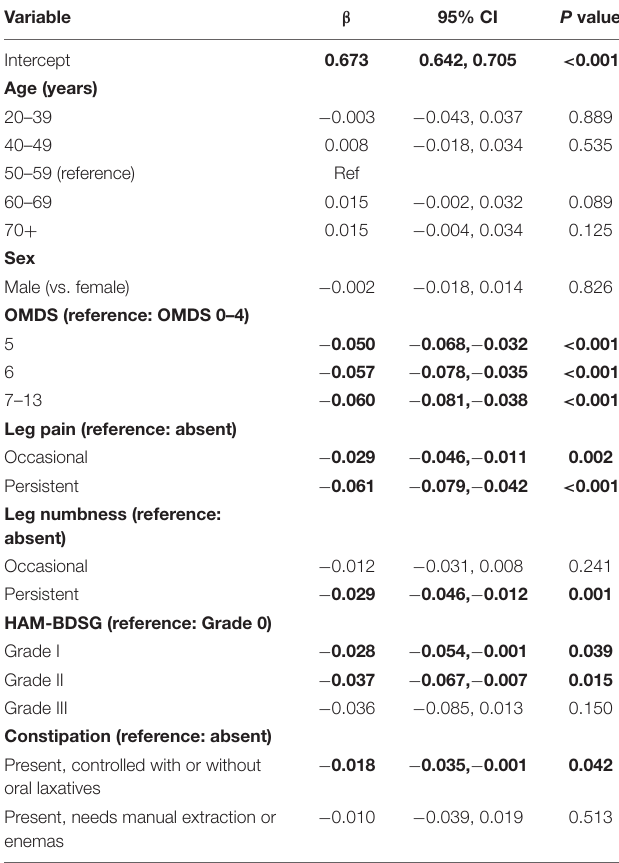
TABLE 3 | Association between the SF-6D and HAM-related